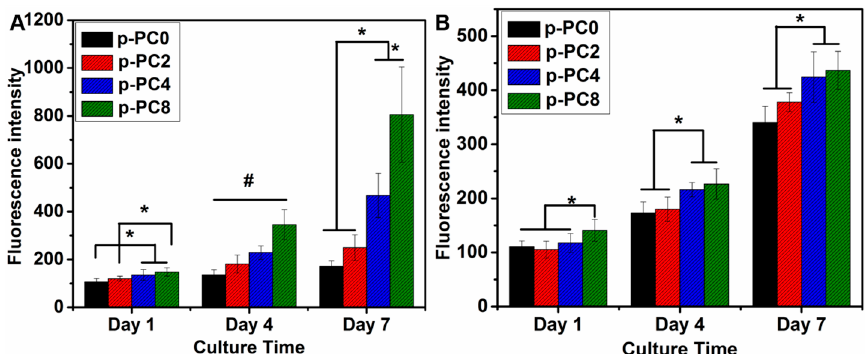
Figure 7. The proliferation of PC12 ( A ) and Schwann cells ( B ) on p-PC0, p-PC2, p-PC4, and p-PC8 nanofibers. (* = significant difference between the labelled two groups; # = significant difference between any two groups. p < 0.05).